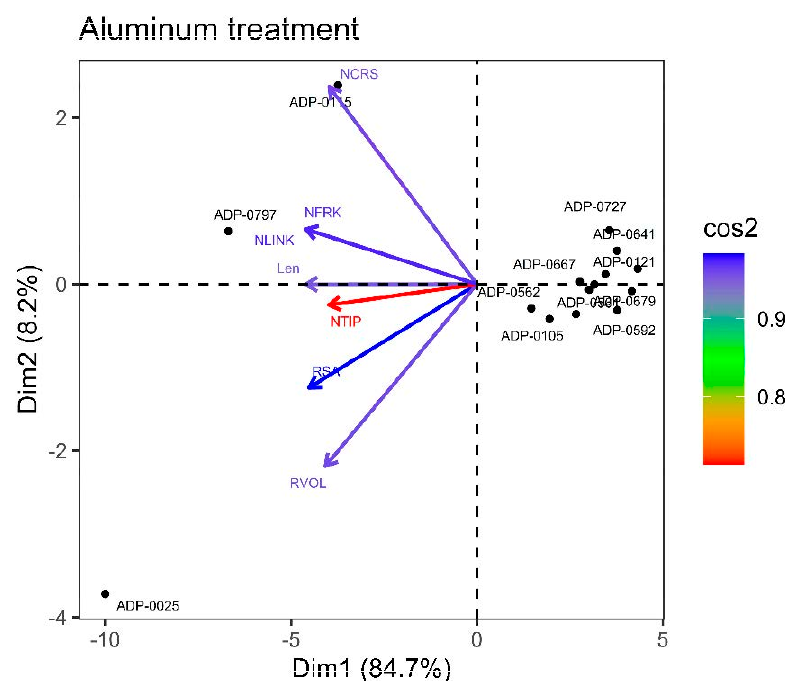
Figure 2. Genotype × trait biplot displaying trait association across seven root traits of Andean common bean genotypes grown under Al stress treatment and top 15 genotypes contributing towards PCA based on Cos 2 value. Abbreviations are the same as in previous tables and the ADP number is as found in the panel description [34].